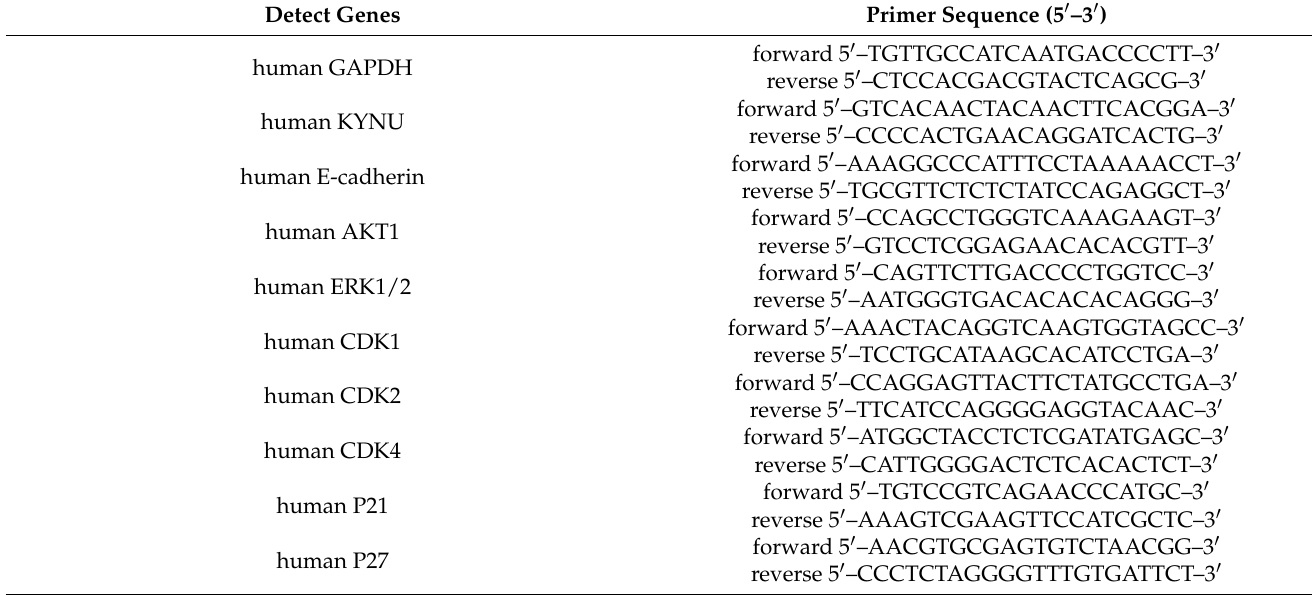
Table 1. Primer sequences in this